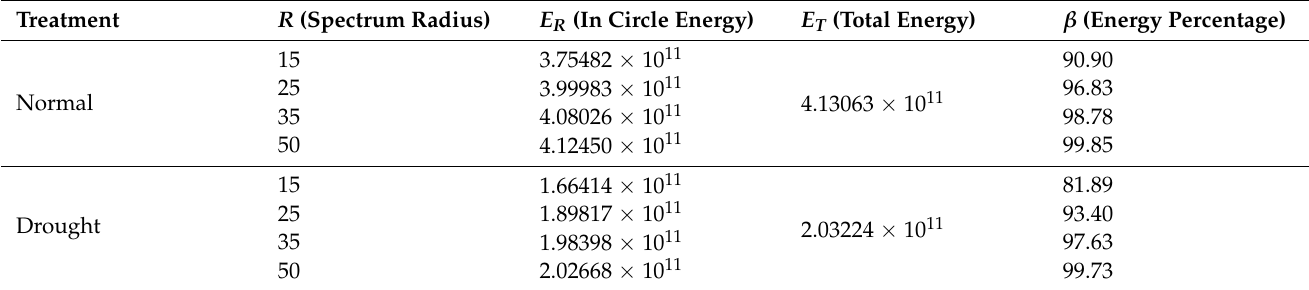
Table 7. Spectrum energy distribution of the soybean canopy in the red-edge